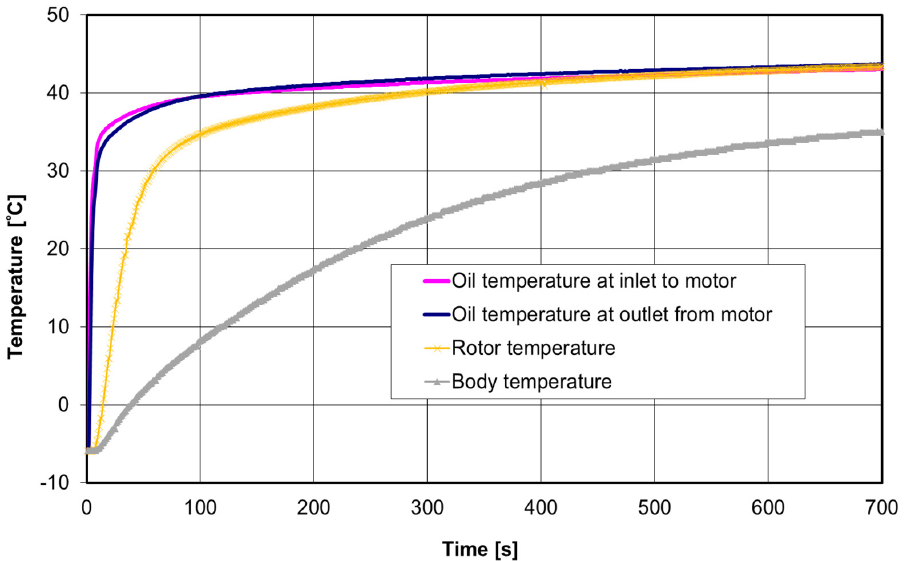
Figure 13. Characteristics of the temperatures of rotor, body, and oil at the inlet and the outlet of the motor as a function of time (ambient temperature (motor) − 6 °C, obtained rotational speed approximately 250 rpm).